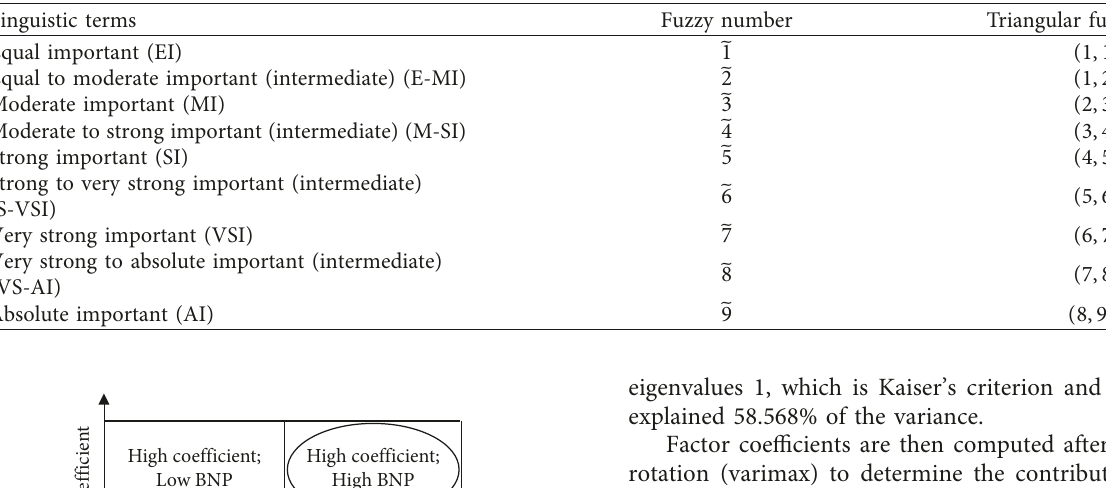
Table 1: Linguistic terms and triangular fuzzy numbers.